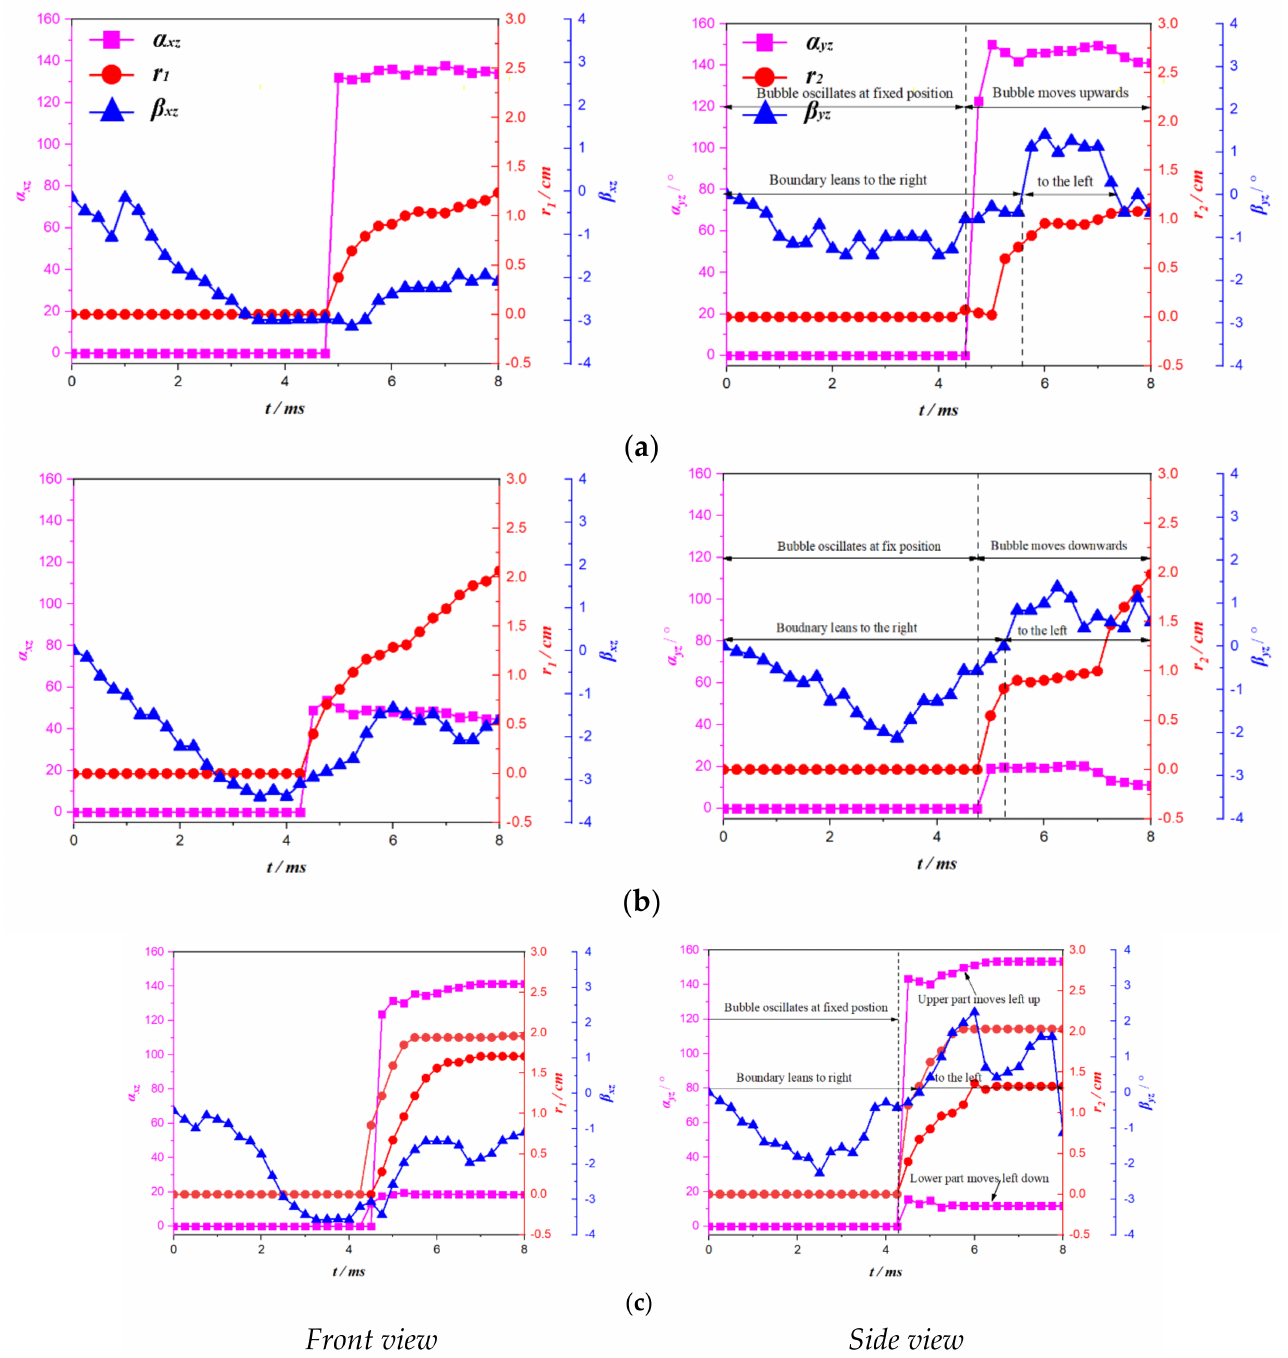
Figure 12. Effect of bending-twisting coupling effect of C-2 plate at different initial positions on bubble migration direction. ( a ) γ = 1.65, ( b ) γ = 1.32, ( c ) γ =